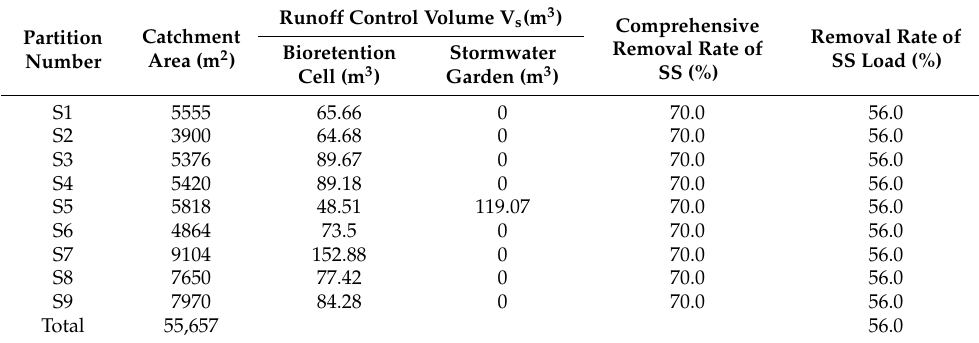
Table 3. Percentage removal of suspended solids (SS) from runoff by sponge facilities in the Shuixi- anghuayuan old residential